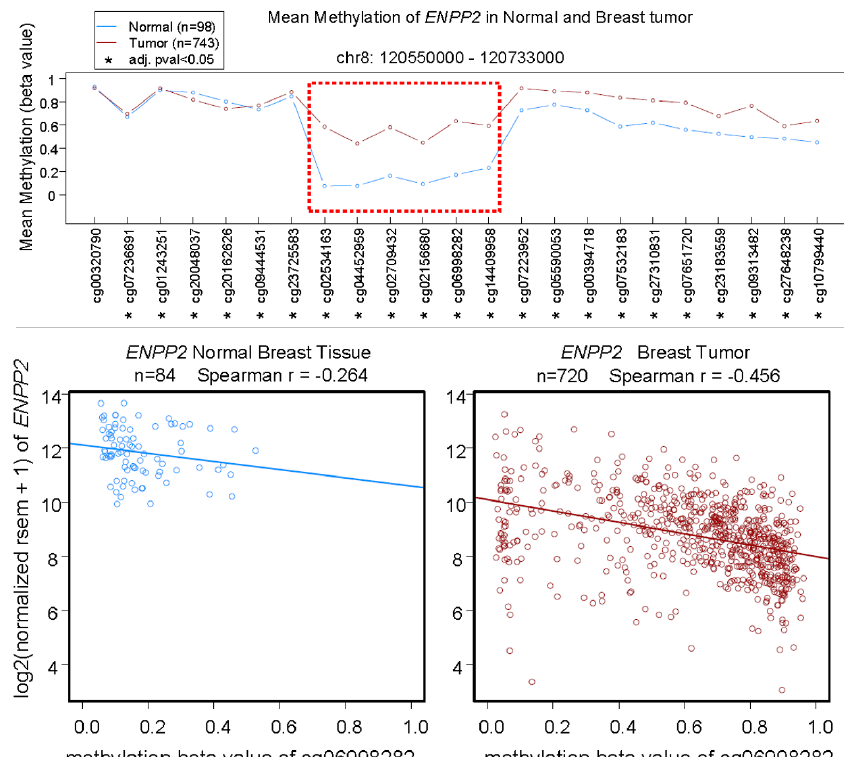
Figure 5. Top: Mean methylation (β values) of ENPP2 in the displayed genomic region of normal breast tissue and breast tumors measured by Illumina HumanMethylation450 BeadChip. Horizontal axis lists the codes of HumanMethylation450 probes for each methylation site. Data are analyzed with Wilcoxon rank sum test, * adjusted p value < 0.05. The most different methylation level between normal and tumor tissue is highlighted by the red box. Bottom: Correlation of mean methylation of ENPP2 at the site for probe cg06998282 and ENPP2 expression in normal breast tissue and breast tumors. Gene expression is expressed in RSEM (RNA-Seq by Expectation-Maximization) format. Data from Wanderer (www.maplab.imppc.org/wanderer) [93].